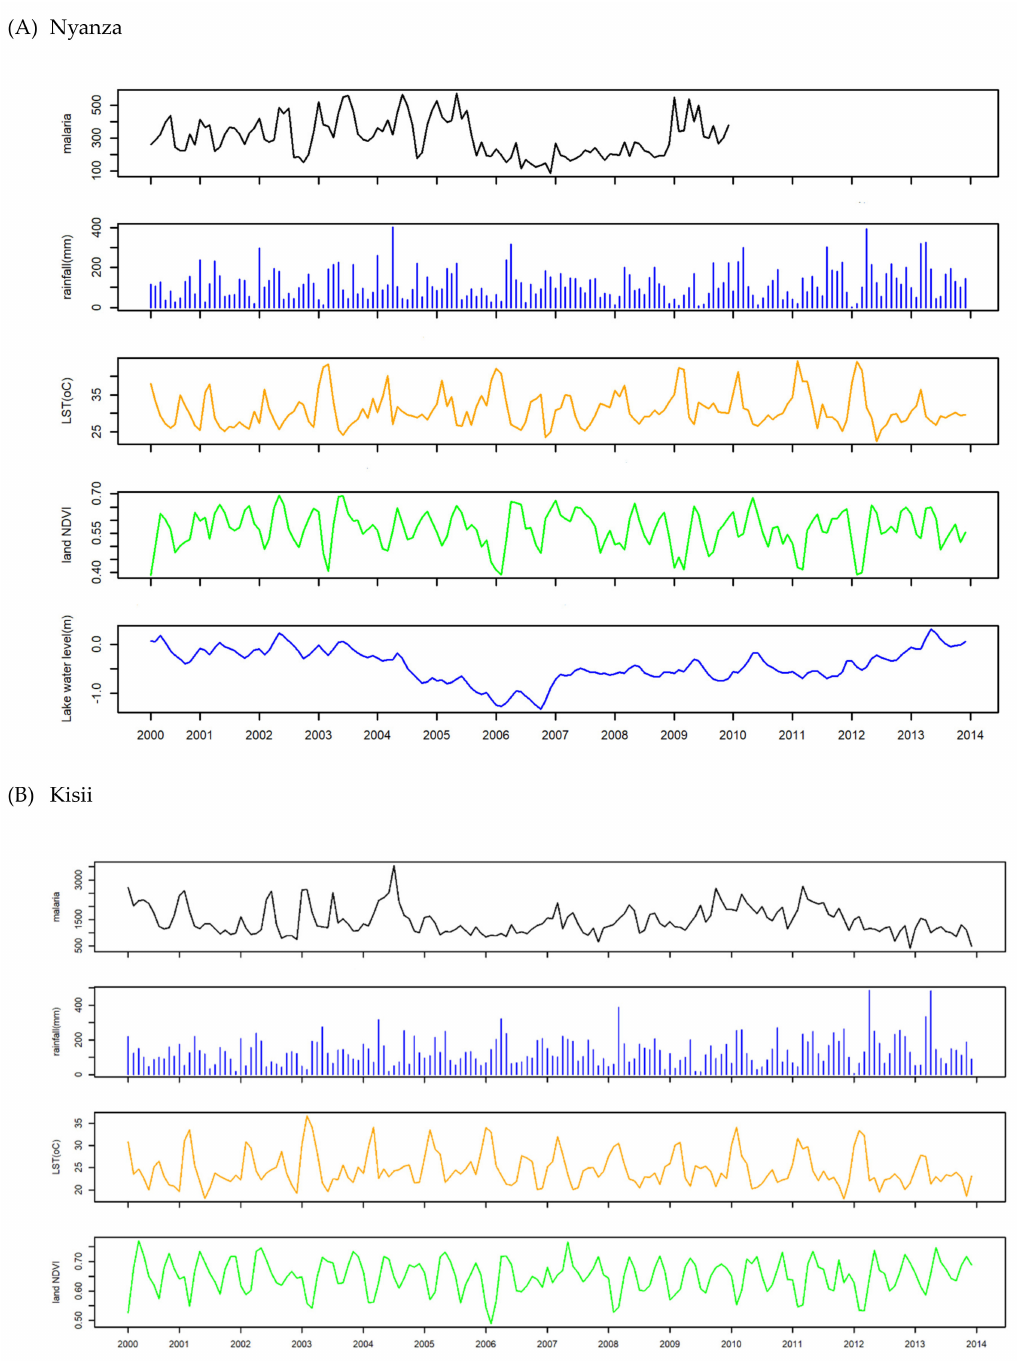
Figure 2. Monthly time-series plots of malaria cases, rainfall, LST, NDVI, and LWL in lowland (Nyanza) and highland